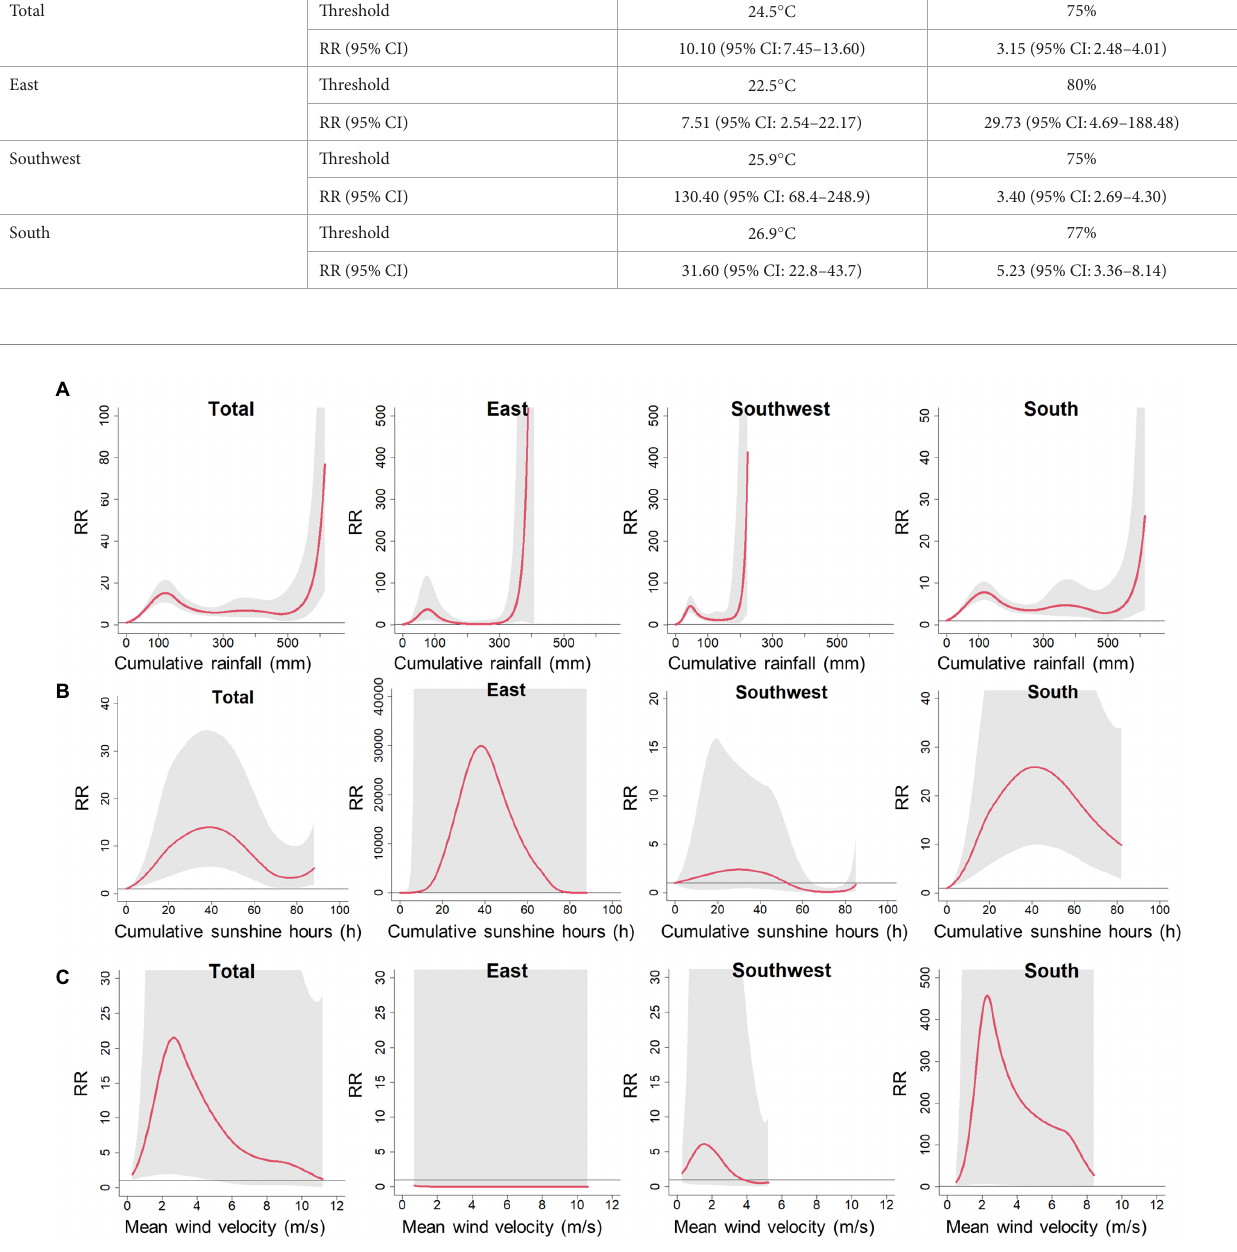
FIGURE 4 Pooled cumulative exposure-response curves for associations between weekly (A) cumulative rainfall, (B) cumulative sunshine hours and (C) mean wind welocity, with scrub typhus incidence over 0–15 lag weeks at total and regional levels. Red solid lines denote the meta-pooled estimates; shaded areas denotes 95% confidence intervals; the reference value for cumulative rainfall, cumulative sunshine hours and mean wind welocity are 0 mm, 0 h and 0 m/s,